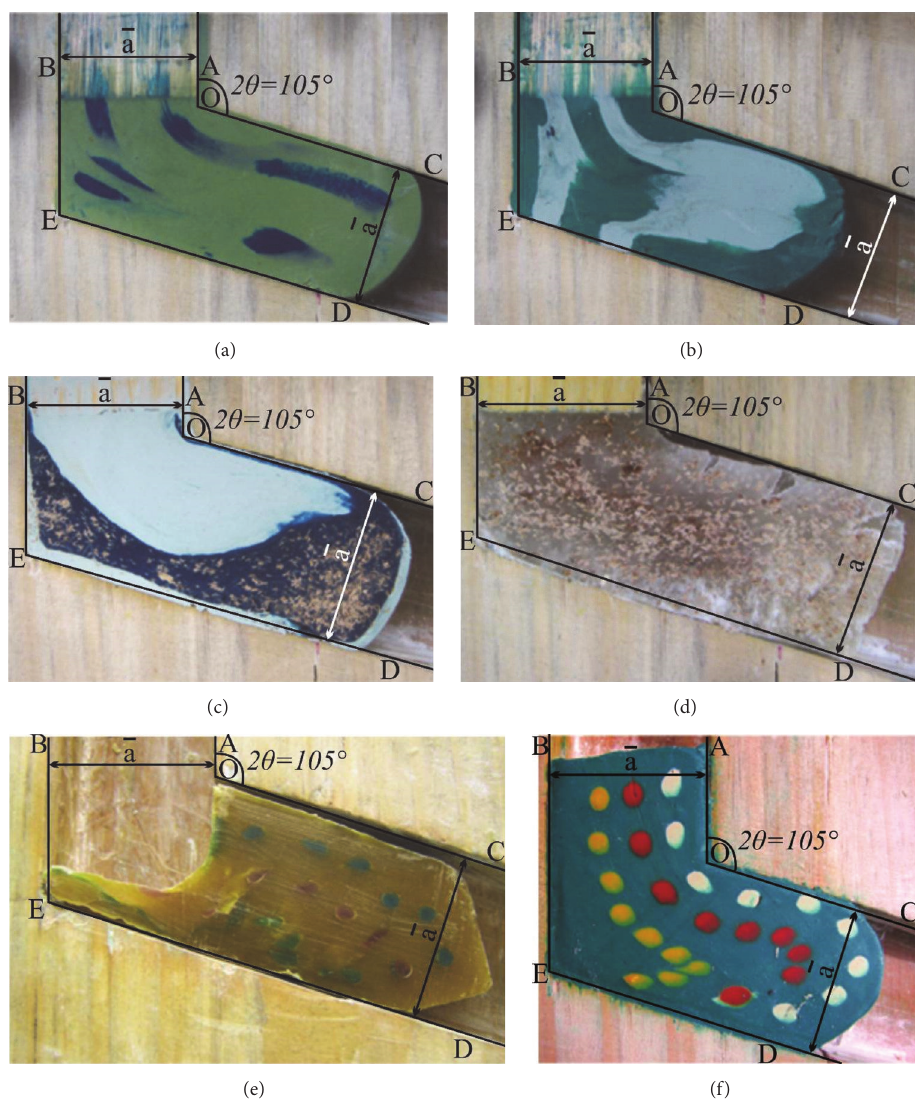
Figure 2: The flow of physical plasticine ((a), (b), (c), (f)), paraffin (d), and wax (e) models of polymer materials through the equal channel angular die AOC–BED of Segal geometry with channel intersection angle ∠ (BED) = ∠ (AOC) = 2 𝜃 = 105 ∘ : (a), (b), (c) the flow of layered plasticine models; (d) the flow of a paraffin workpiece with additional dispersed particles at the front surface of the workpiece in the form of partially immersed fine sawdust; (e) the flow of the yellow wax workpiece with the initial circular colored gridlines in the shape of the initial colored cylindrical wax inclusions with blue, red and green colors; (f) the flow of the blue plasticine workpiece with the initial circular colored gridlines in the shape of initial colored cylindrical plasticine inclusions with white, red, and yellow